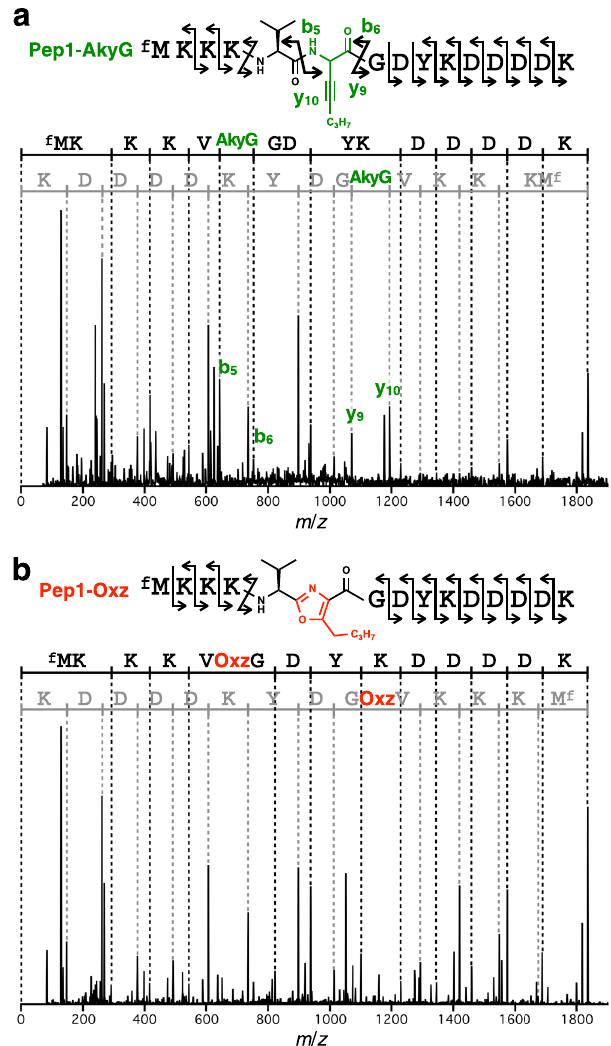
Fig. 3 Identi fi cation of Pep1-AkyG and Pep1-Oxz by MS/MS. a , b MS/MS spectra of peaks observed at a Rt = 8.48 min (Pep1-AkyG) and b Rt = 9.53 min (Pep1-Oxz). Observed b-ion series and y-ion series fragmentations are shown on the sequences in black and gray, respectively. The peaks corresponding to the key fragmentations that discriminate the two compounds (b 5 , b 6 , y 9 , and y 10 ) are labeled